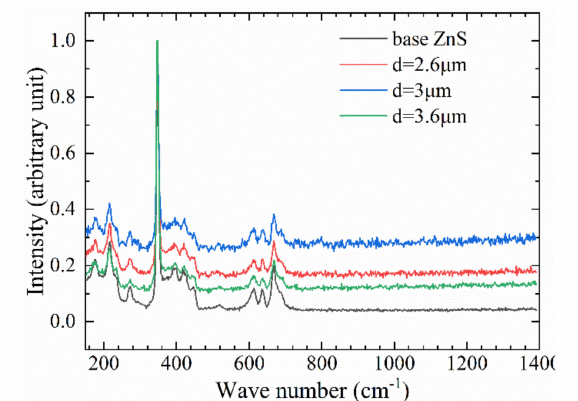
Figure 8. Raman Spectroscopy of ZnS